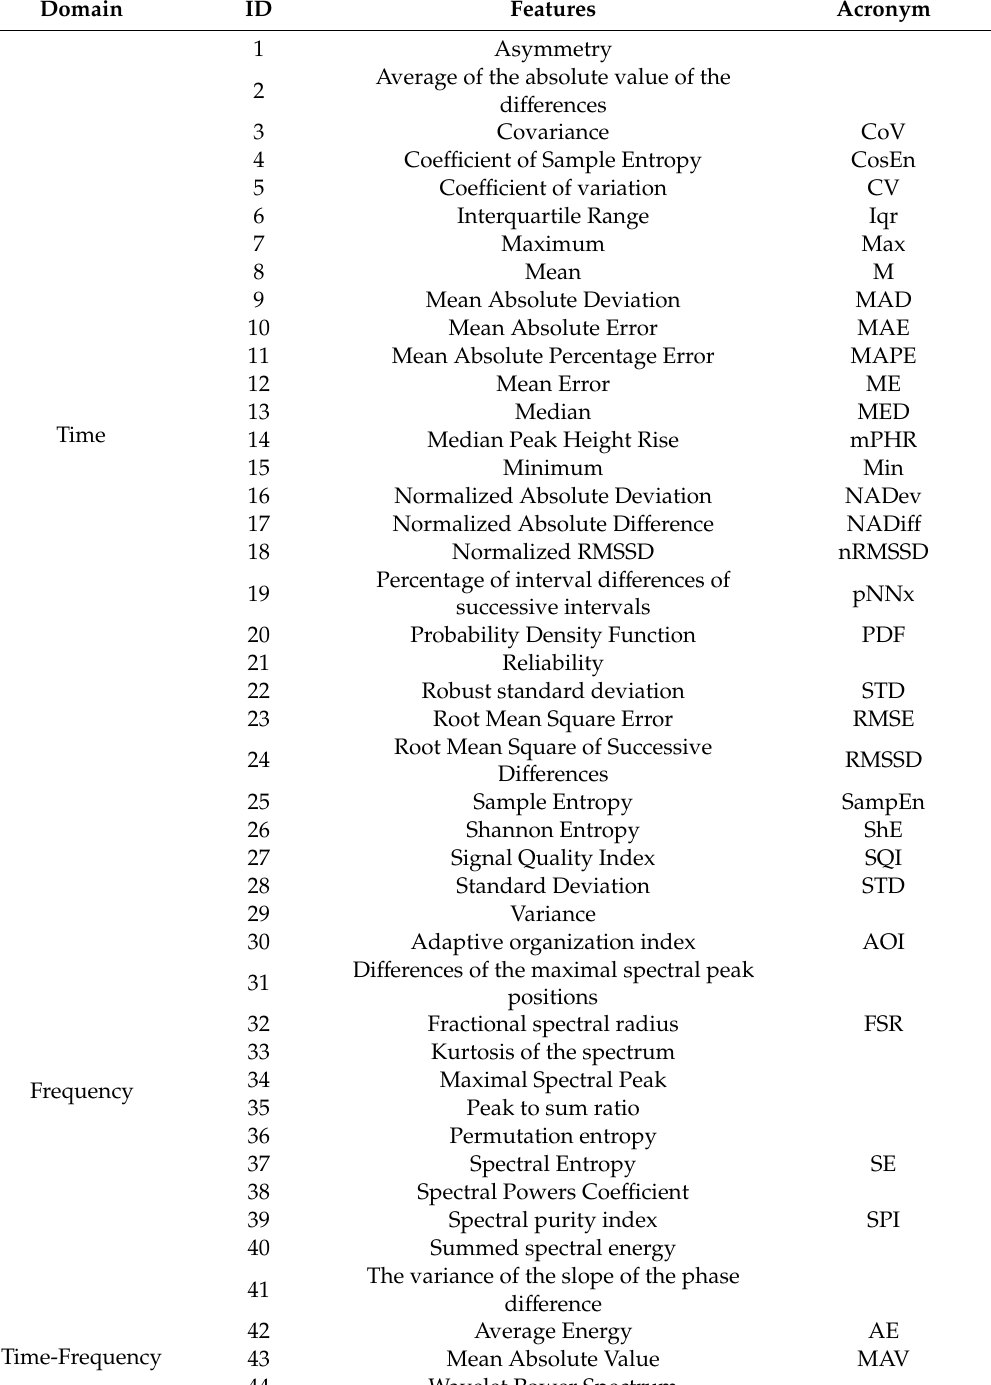
Table 3. List of features extracted from the PPG signal that is used for AF detection. Domain